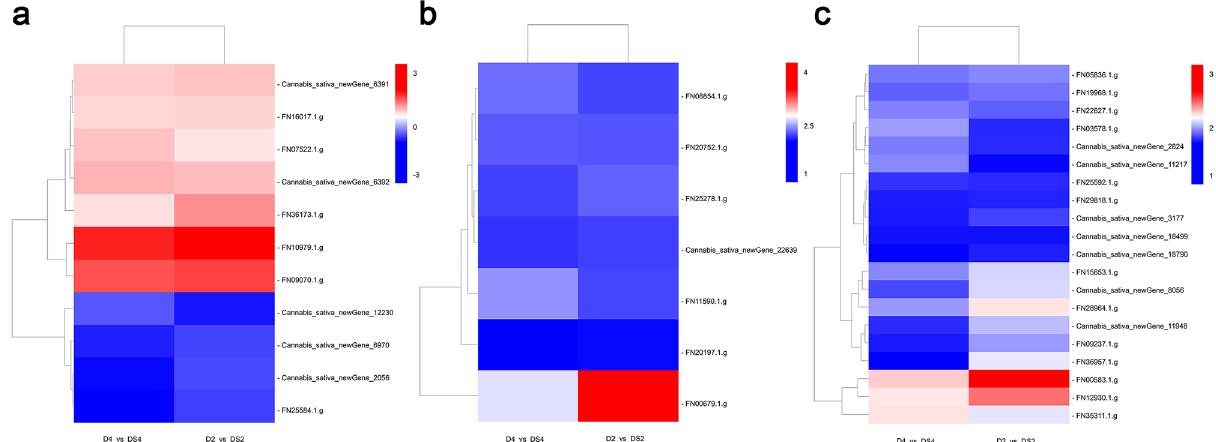
Figure 6. Heatmap of the DEGs in porphyrin and chlorophyll metabolism, photosynthesis-antenna proteins and photosynthesis between D and DS. The expression level changes of genes in each group were described as log 2 fold change of FPKM. Colors indicated up- and down-regulated levels of genes. Uniconazole-induced expression patterns of 11 porphyrin and chlorophyll metabolism genes under drought stress ( a ). Uniconazole- induced expression patterns of 7 photosynthesis-antenna proteins genes under drought stress ( b ). Uniconazole- induced expression patterns of 20 photosynthesis genes under drought stress ( c ). D2_vs_DS2 means drought stress for 2 days/drought stress treated with uniconazole for 2 days; D4_vs_DS4 means drought stress for 4 days/ drought stress treated with uniconazole for 4 days. The heatmap was constructed using the drawing tools of